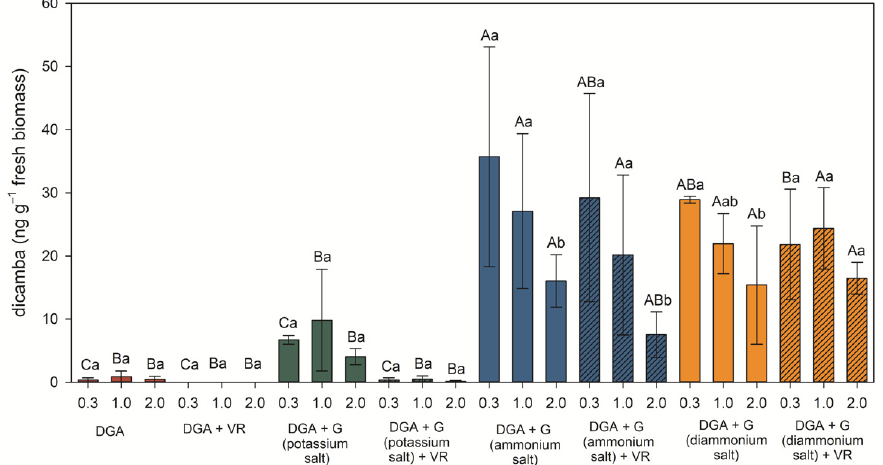
Figure 3. Dicamba concentrations in soybean plants at distances of 0.3, 1.0, and 2.0 m from the trays treated with dicamba in different associations and allocated within the low tunnels. The error bars represent the confidence interval ( p ≤ 0.05). Averages followed by the same upper-case letter do not differ from each other for the treatments (sprayed solution) according to LSD test ( p ≤ 0.05). Averages followed by the same lower-case letter do not differ from each other for the distances of trays according to the LSD test ( p ≤ 0.05). VR: volatility reducer; DGA: dicamba diglycolamine salt; G: glyphosate.